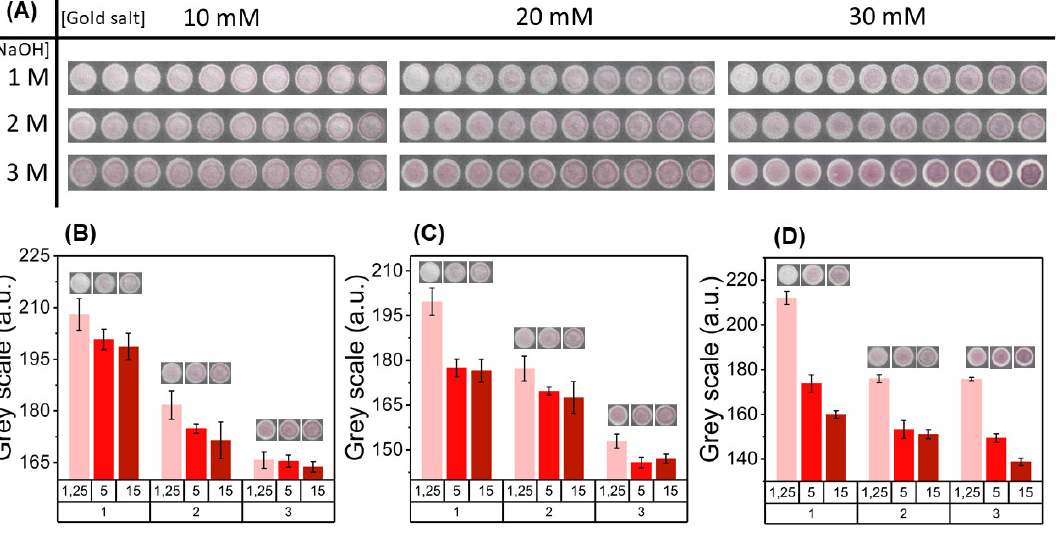
Figure 2. Optimization of colorimetric signals for the paper-based glucose assay. ( A ) Assay performed for different reaction parameters and the corresponding color signals. Three different HAuCl 4 concentrations (10, 20, and 30 mM, 2.5 μL) and NaOH (1, 2, and 3 M, 2 μL) were used to determine how these reaction parameters influence the color achieved in the reaction zones. ( B ) Histograms of color signal intensity (grey scale value) comparison for 10 mM HAuCl 4 concentration and three glucose concentrations (1.25, 5, and 15 mM). ( C ) Histograms of color signal intensity (grey scale value) comparison for 20 mM HAuCl 4 concentration. ( D ) Histograms of color signal intensity (grey scale value) comparison for 30 mM HAuCl 4